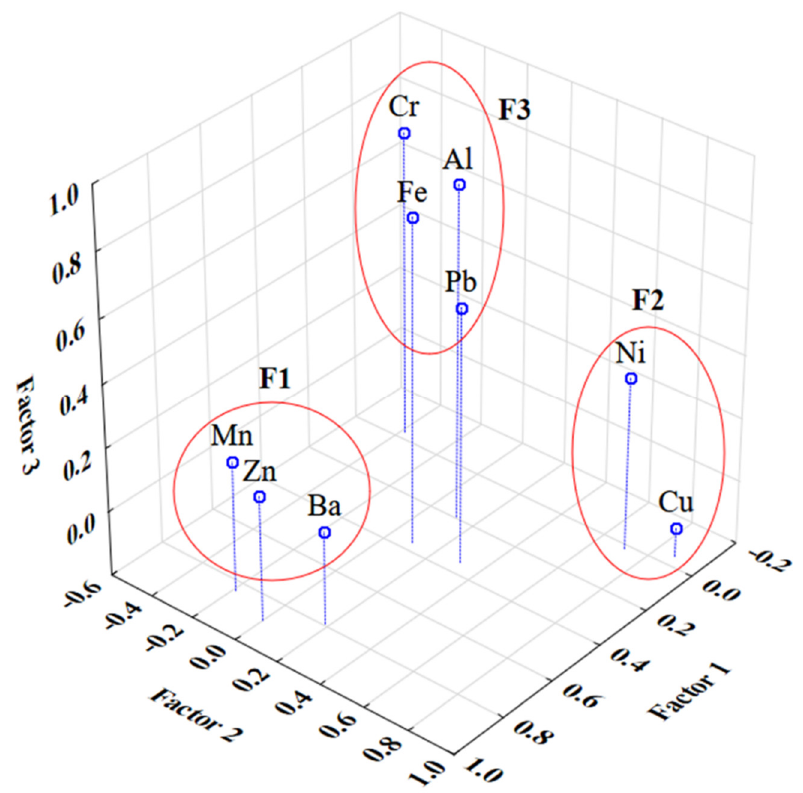
Figure 2. Factorial loads showing the behavior of PTEs.